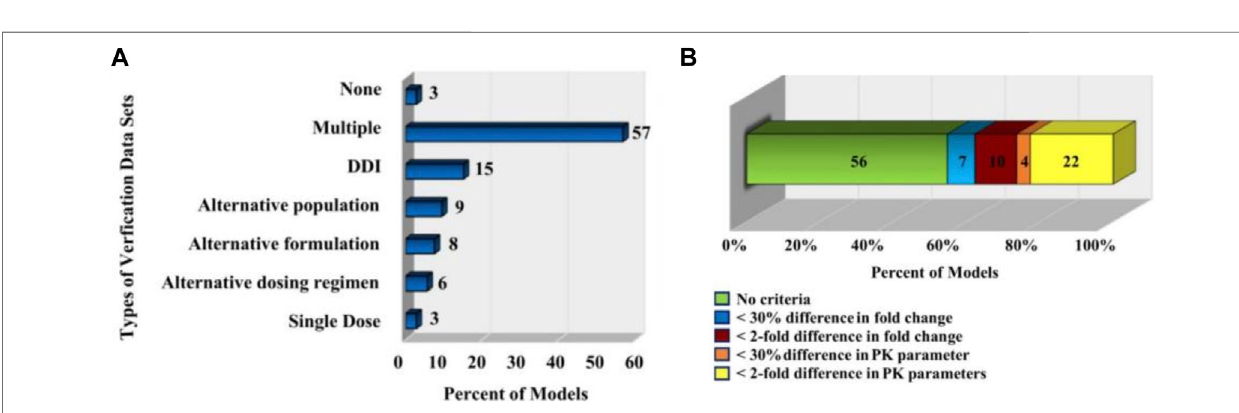
FIGURE 6 | PBPK model validation. (A) The types of in vivo datasets used to verify the quality of the models (Sager et al., 2015). (B) The distribution of the acceptance criteria used in PBPK models (Sager et al., 2015).